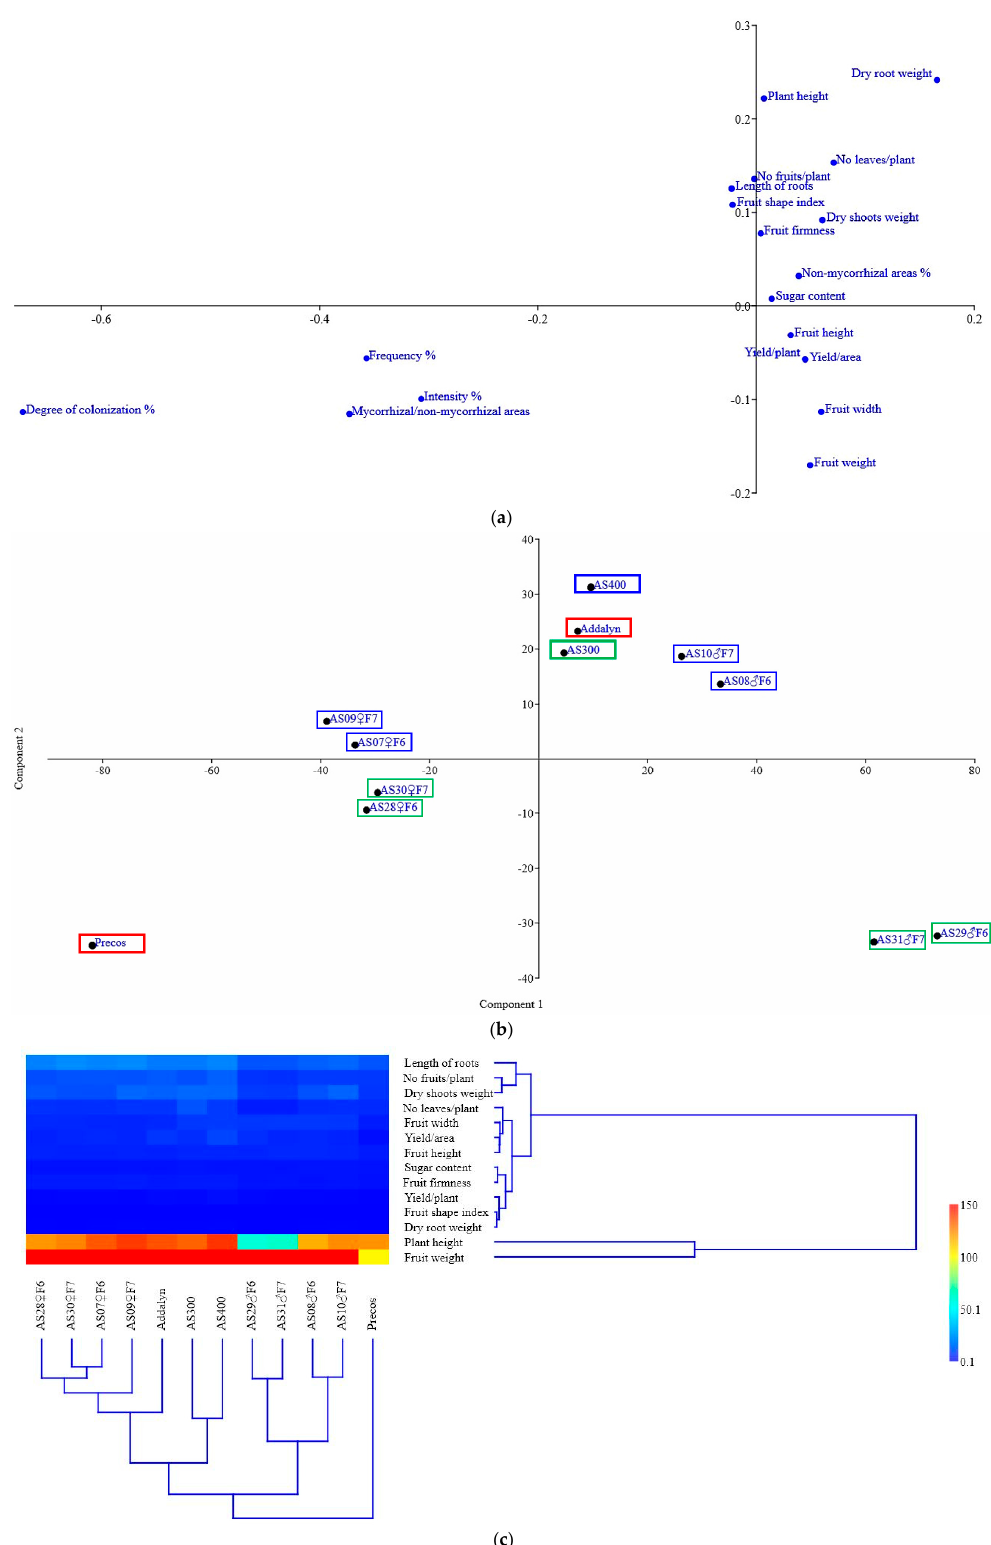
Figure 4. Multivariate analyses performed for traits of plant growth, yield, and fruit quality in 12 tomato genotypes: ( a ) Correspondence analysis (CA), 19 parameters analyzed; ( b ) Principal Com- ponent Analysis (PCA), 19 parameters analyzed; ( c ) Hierarchical clustering, paired group UPGMA (Unweighted Pair Group Method with Arithmetic Mean), similarity index (Gower), 14 parameters analyzed (without mycorrhizal ones).